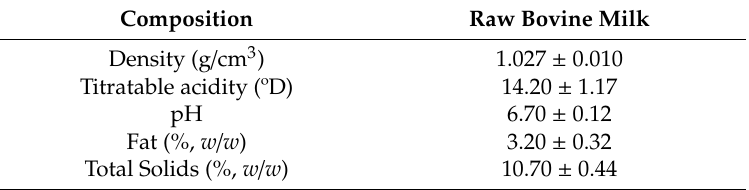
Table 2. Physicochemical composition of milk used in the production of costeño-type cheese.